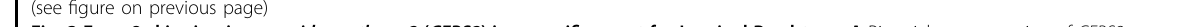
Fig. 3 Exon 8 skipping in ceramide synthase 2 ( CERS2 ) is a speci fi c event for Luminal B subtype. A Pictorial representation of CERS2 gene and corresponding protein showing the distinct Hox-like domain, Tram-Lag-CLN8 (TLC) domain, and Lag1p motif. B Two CE events predicted for CERS2 where AS1 generates a transcript in which exon 8 (205 – 247 amino acids) is skipped, and AS2 event generates a transcript with 33 bp of intron 6 – 7 retained and loss of exon 7 and 8 (174 – 247 amino acids). C , D Isoform-speci fi c qRT-PCR (mean ± SD, n = 6) for CERS2 full-length protein-coding (PC) transcript ( C ) and alternatively spliced AS1 transcript lacking Exon 8 ( D ) in MCF-10A, BT-474 (Luminal B), and MDA-MB-453 (HER2 + ) cells con fi rm differential expression of the isoforms in BT-474 cells as compared to MCF-10A and MDA-MB-453 cells. A pictorial representation of exon/intron position and primer sites are also shown. E Immunoblot of CERS2 from MCF-10A and representative subtype-speci fi c breast cancer cells show a single band corresponding to full-length protein-coding (PC) CERS2 protein. F Polysome analysis of BT-474 cells shows A260 tracing of fractions in upper panel. Bottom panel shows qRT-PCR analysis of fractions as listed at the bottom of the gel image. Panel PC shows full-length protein-coding (PC) mRNA speci fi c product, and panel AS shows alternatively spliced mRNA (AS1) speci fi c product. Red arrow indicates correct size for the alternate spliced mRNA in the polysome fractions while the asterisk indicates a non-speci fi c product. Numbers on the left-hand side of the gel indicate the length of marker DNA in base pairs. Data in ( C , D ) were analyzed by